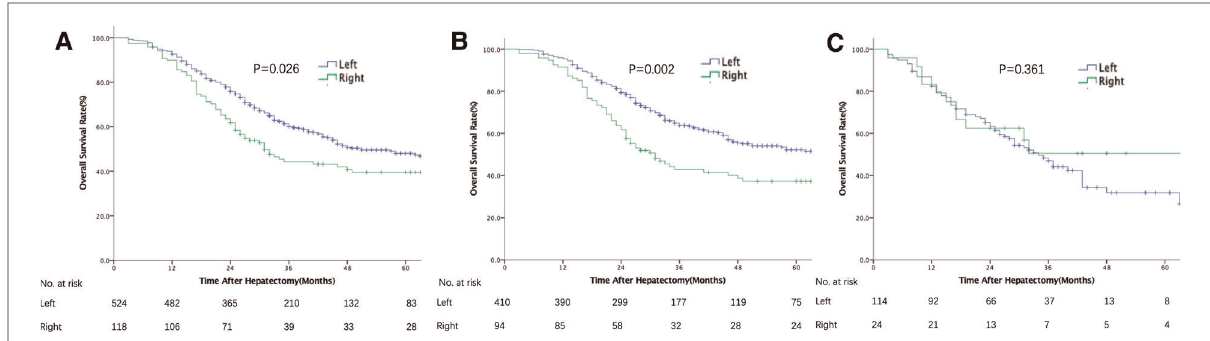
FIGURE 1 Overall survival after resection of colorectal liver metastases strati fi ed by primary tumor location (left vs. right). ( A ) In the entire cohort. ( B ) In patients with TBS <7. ( C ) In patients with TBS ≥ 7.